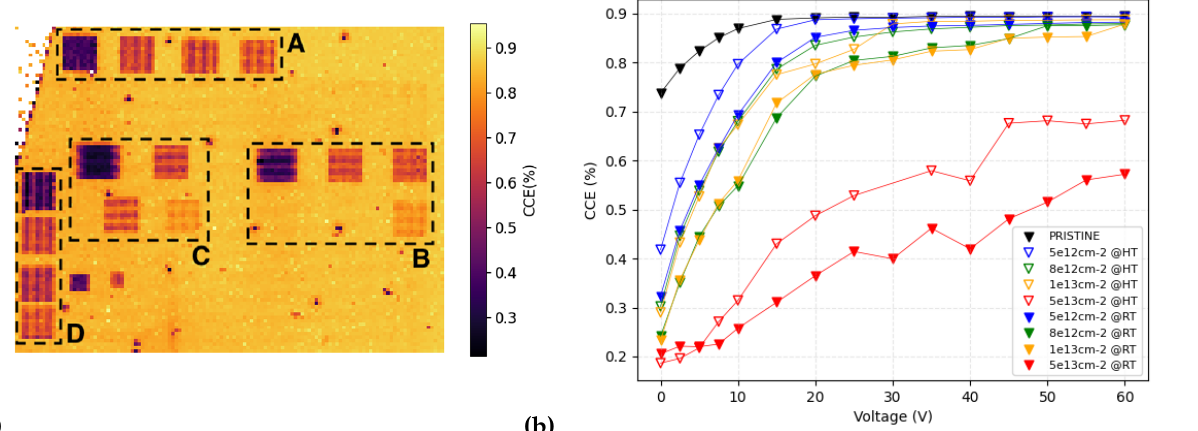
Figure 5. ( a ) IBIC map acquired at 10 V on the sensor region containing the damaged areas. The framed areas in the A region were irradiated at room temperature, and the B areas at 500 ◦ C, both on the bulk. The C and D areas are located on the membrane irradiated at room temperature and 500 °C, respectively. The color-bar on the right shows the CCE values. ( b ) CCE as a function of the applied bias voltage. Different colors indicate different irradiance fluences, full markers indicate measurements performed in A region (room temperature), while empty ones indicate B region (500 ◦